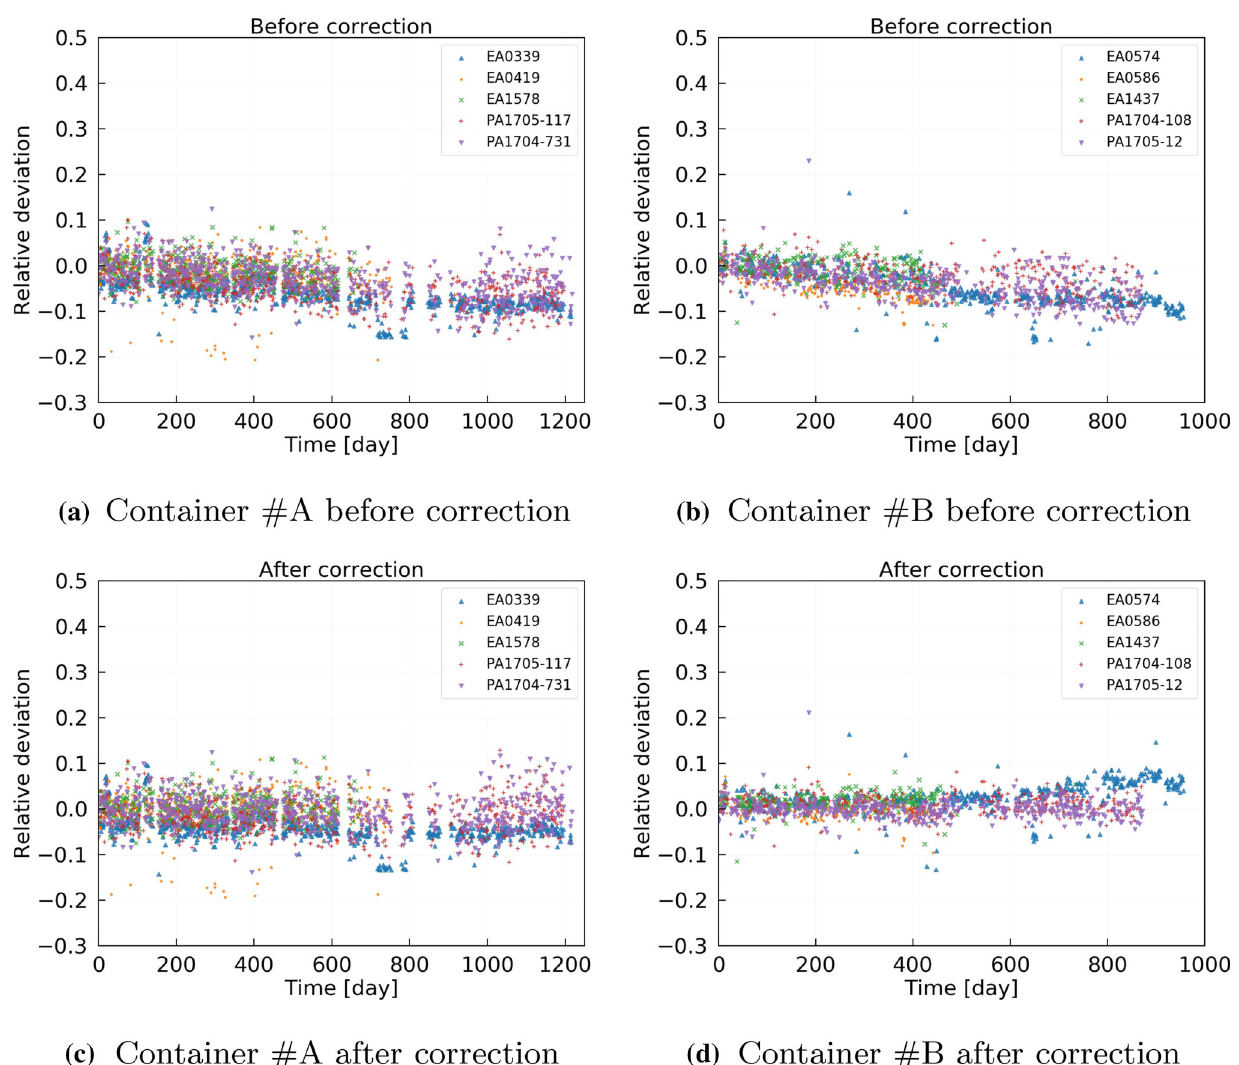
Fig. 18 Relative variation of the measured PDE of the monitoring PMTs (HPK PMTs tagged by “EA”, NNVT PMTs tagged by “PA”) at the container system, before and after a correction based on a recal- ibration at the end of the regular testing period. Indicated variation is